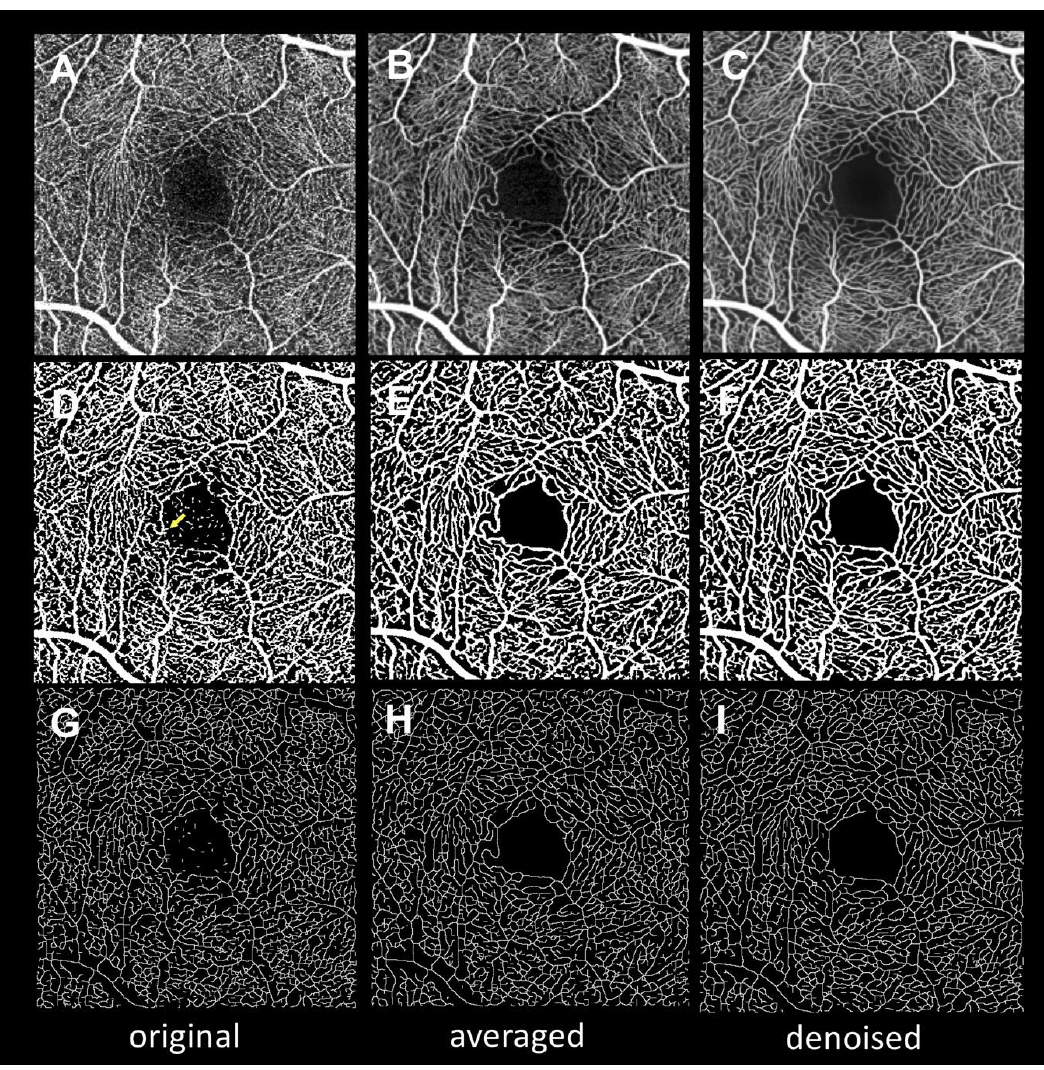
Figure 2. Binarization and skeletonization of en face optical coherence tomography angiography (OCTA) of original, averaged, and denoised images. ( A–C ), OCTA images. ( D–F ), Binarized images. ( G–I ), Skeletonized images. A, D, G, Original images. B, E, H, Averaged images. C, F, I, Denoised images. The binarized image in D shows multiple noise in the foveal avascular zone (FAZ) and burr-like shape at the edges of the vessels (indicated by an arrow), suggesting that background noise could have been falsely included as blood flow. The binarized images of the averaged and denoised images in E and F show less noise and smoother vessels than the original image in D. The skeletonized image in G shows disconnected lines and dots in nonvascular areas. Compared with the original image in G, the skeletonized images of the averaged and denoised images in H and I show annealing lines that reduce the disconnected lines and dots.